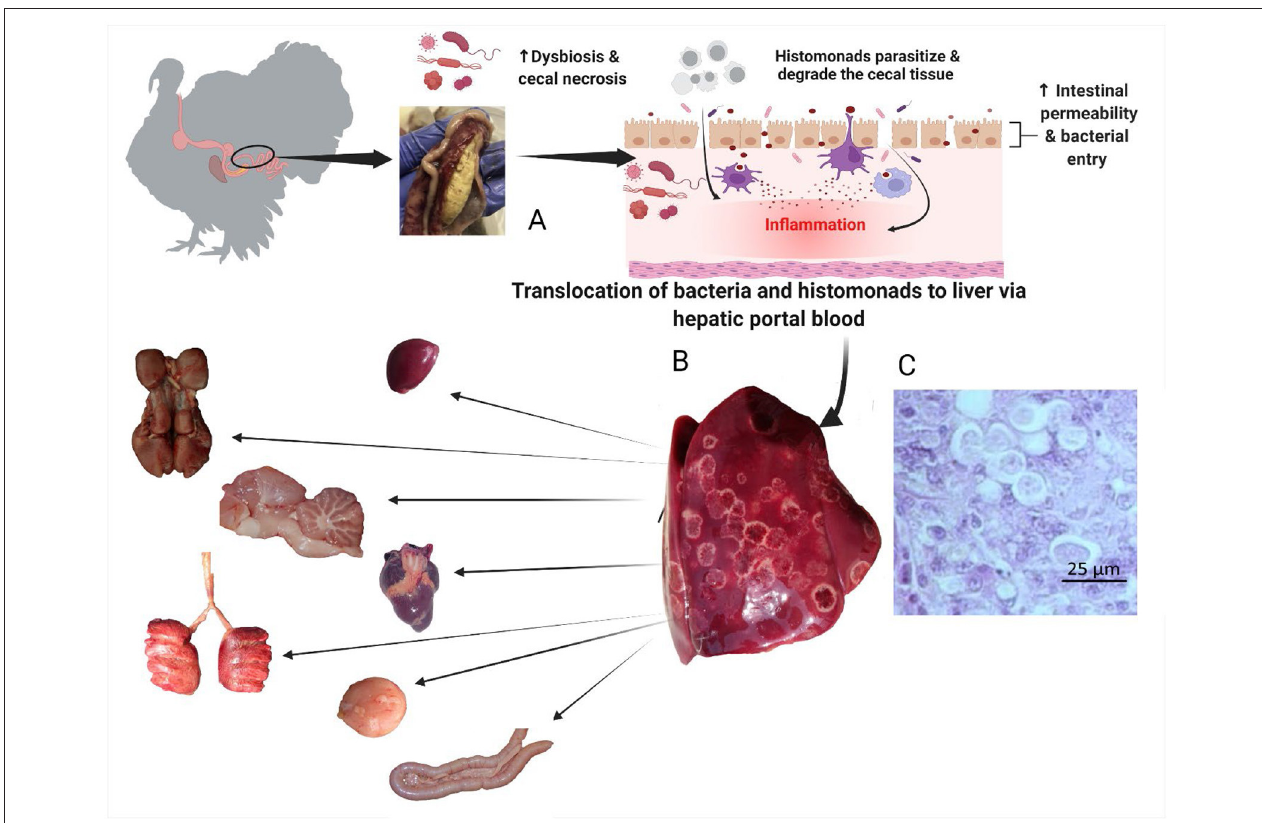
FIGURE 4 | Pathogenesis of histomonosis. The parasite induces a severe inflammatory reaction in the ceca. The inflammatory reaction is followed by necrosis, with dysbiosis causing increased permeability in the ceca (B) . This allows bacterial and parasitic translocation to the liver via hepatic portal blood; the resulting pathognomonic lesions are exhibited as target-like liver lesions and caseous cecal cores (A) . Histomonas meleagridis in the liver of a turkey, Periodic acid–Schiff (PAS), 40 × (C) . From the liver, bacteria and histomonads migrate to other parenchymal organs (spleen, heart, kidneys, pancreas, lungs, brain, bursa of Fabricius) causing chronic systemic inflammation and multiple organ failure (Created with